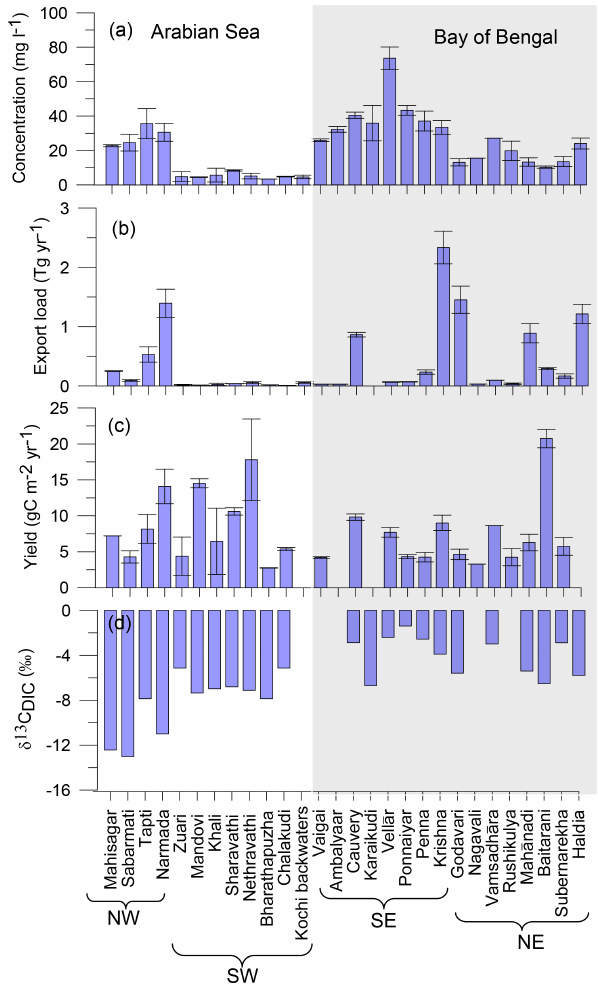
Figure 3. Spatial variability in the concentration (mgL − 1 ; a ), ex- port flux (Tgyr − 1 ; b ) and yield (gm − 2 yr − 1 ; c ) of dissolved in- organic carbon (DIC) and its stable isotopes ( δ 13 C DIC ; d ) in the Indian monsoonal rivers studied. Rivers geographically located in the northwest (NW), southwest (SW), southeast (SE) and north- east (NE) regions of India were also shown. Rivers draining into the Bay of Bengal (east-flowing rivers) were shown with gray shad- ing, while rivers draining into the Arabian Sea (west-flowing) were shown with no